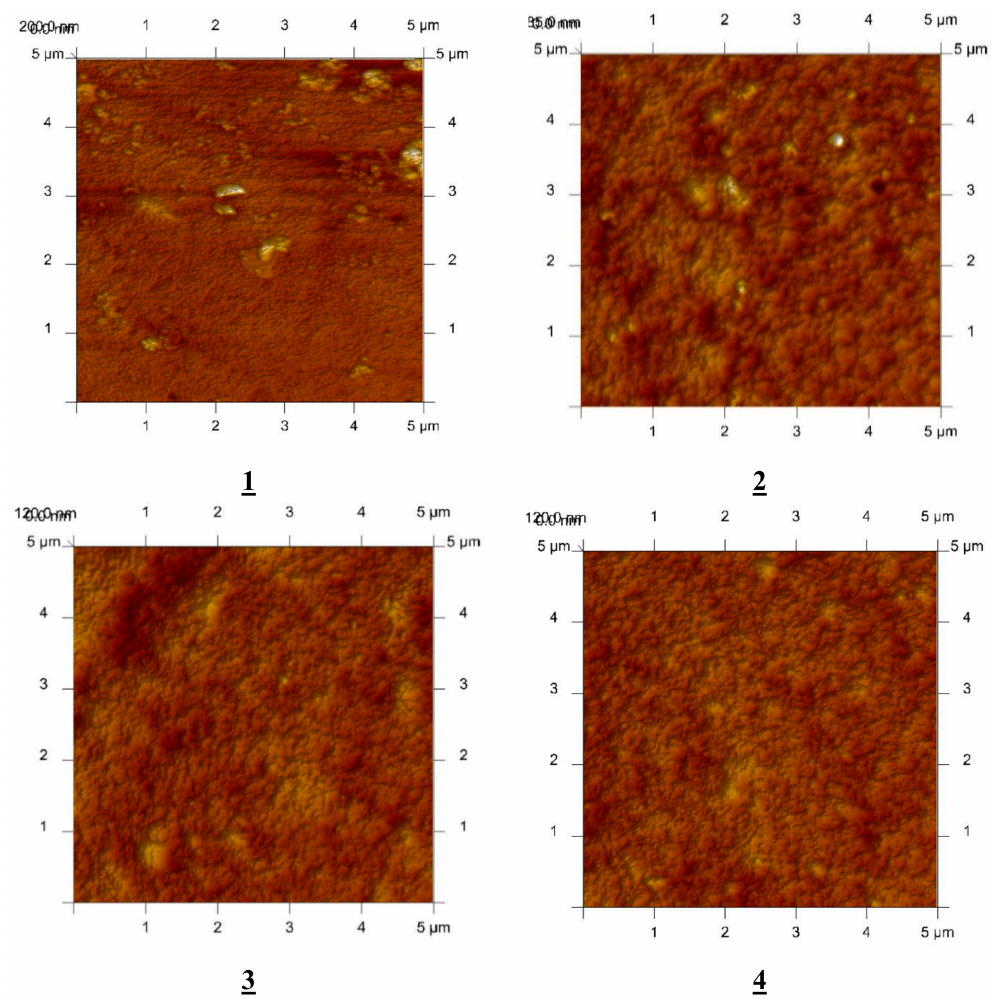
Figure 3. 2D-view atomic force micrographs (AFMs) of PIMs with 1-octylimidazole ( 1 ), 1-octyl-2-methylimidazole ( 2 ), 1-octyl-4-methylimidazole ( 3 ), and 1-octyl-2,4-dimethylimidazole ( 4 ), at a 60% carrier concentration. Scan area: 5 × 5 µ